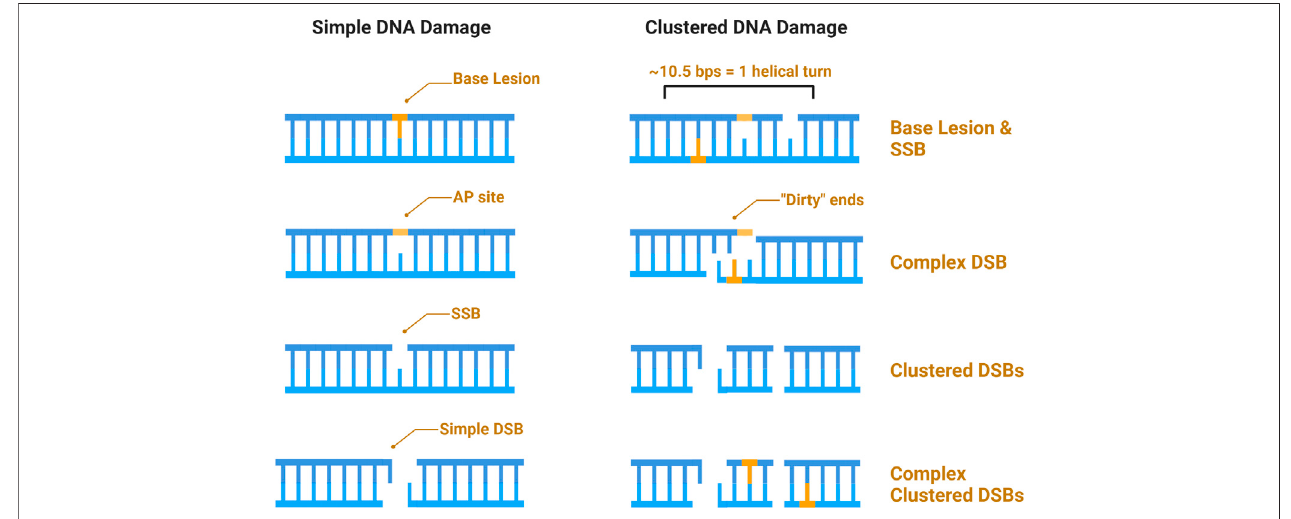
FIGURE 3 | Schematic of IR induced DNA damage. Simple damage includes base lesions such as oxidized bases, apurinic or apyrimidinic sites (AP sites), and isolated strand breaks. Clustered damage occurring within 1 – 2 helical turns can be comprised of ≥ 2 simple lesions which may be non-DSB oxidative clustered DNA lesions (OCDLs) or clustered DSBs. Strand breaks can also be complex, with additional base lesions comprising “ dirty ends ” .